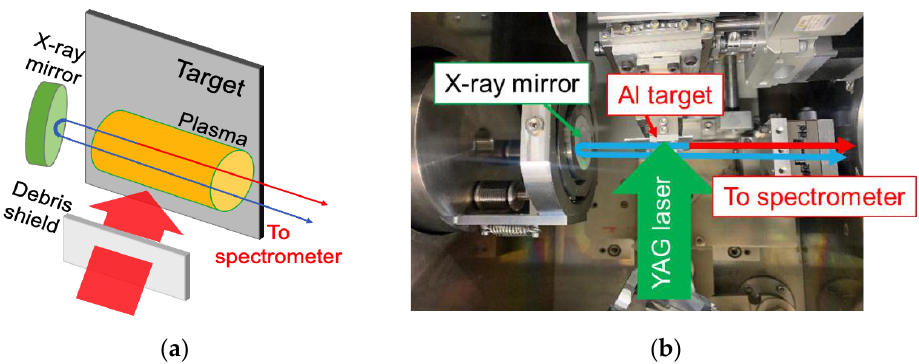
Figure 1. ( a ) Schematic of single resonator for 15.5 nm Li-like Al X-ray laser. ( b ) Photograph of the experimental setup for the double pass amplification.